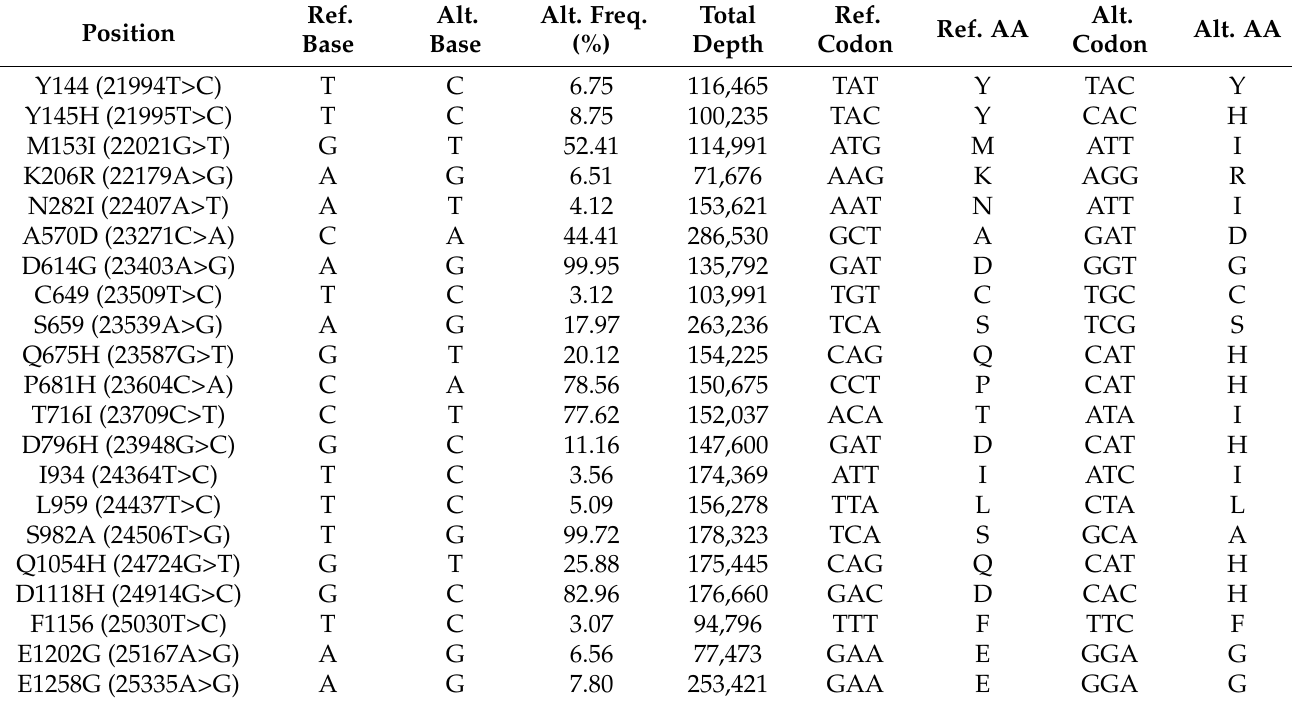
Table 3. Genomic variation profile (SNVs) within the S gene of SARS-CoV-2 by targeted DNA-seq. Position